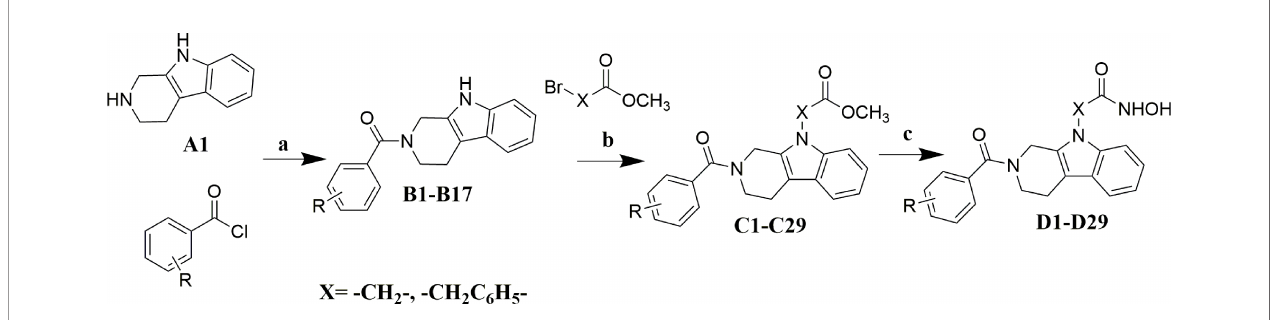
b -carboline scaffold was utilized for the occupation of target compounds to the hydrophobic pocket of APN. In the enzyme inhibitory assay, K562-CD13 monoclonal cells were used as APN enzyme source as described in our previous work (27). The derived target molecules were fi rstly screened at the concentration of 30 µM; then, compounds with inhibitory rate higher than 55% were further investigated for the IC 50 value ( Table 1 and Figures 2A, B ). Notably, molecules with a short linker (CH 2 ) between hydroxamic acid group and tetrahydro- b - carboline group exhibited better inhibitory activities than